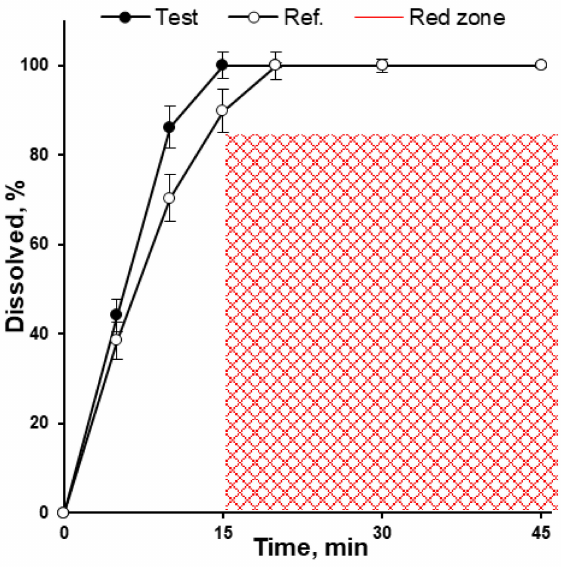
Figure 9. Isoniazid tablets drug release testing in 900 mL volume of pH 1.2 at 75 rpm ( n = 6). The “red zone” is showing the area beyond of biowaiver specification for the dissolution test